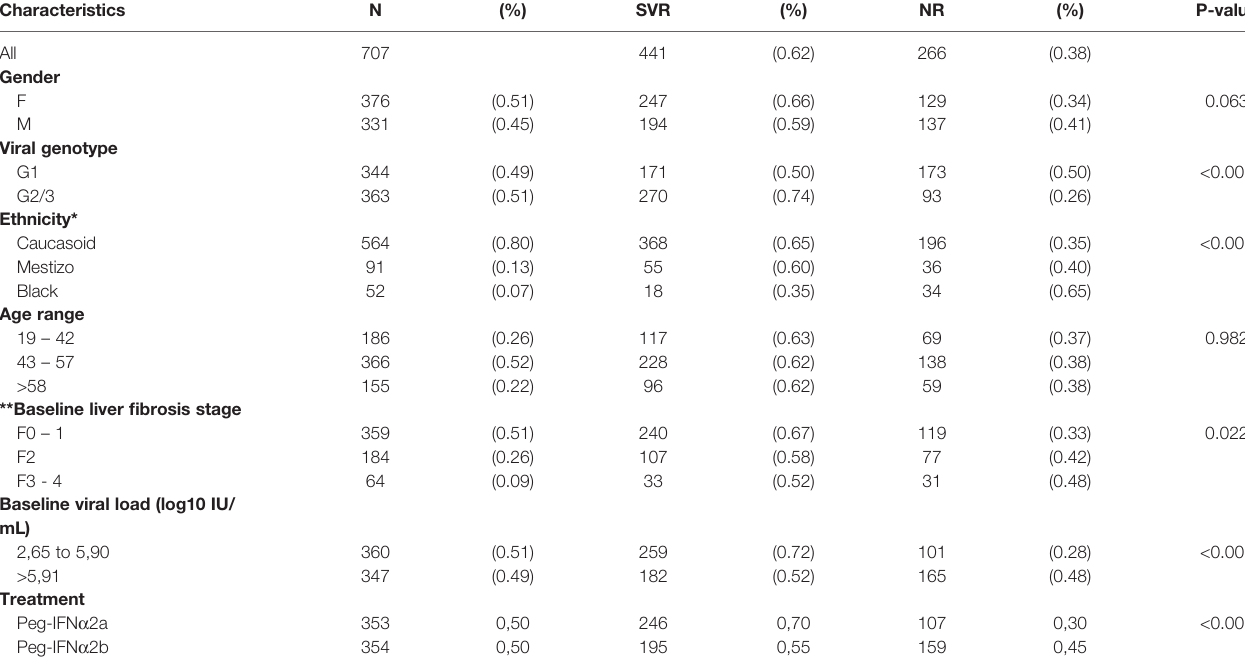
TABLE 1 | Baseline demographics, clinical characteristics, viral genotype and outcome of CHC treatment with pegylated IFN- a and Ribavirin.